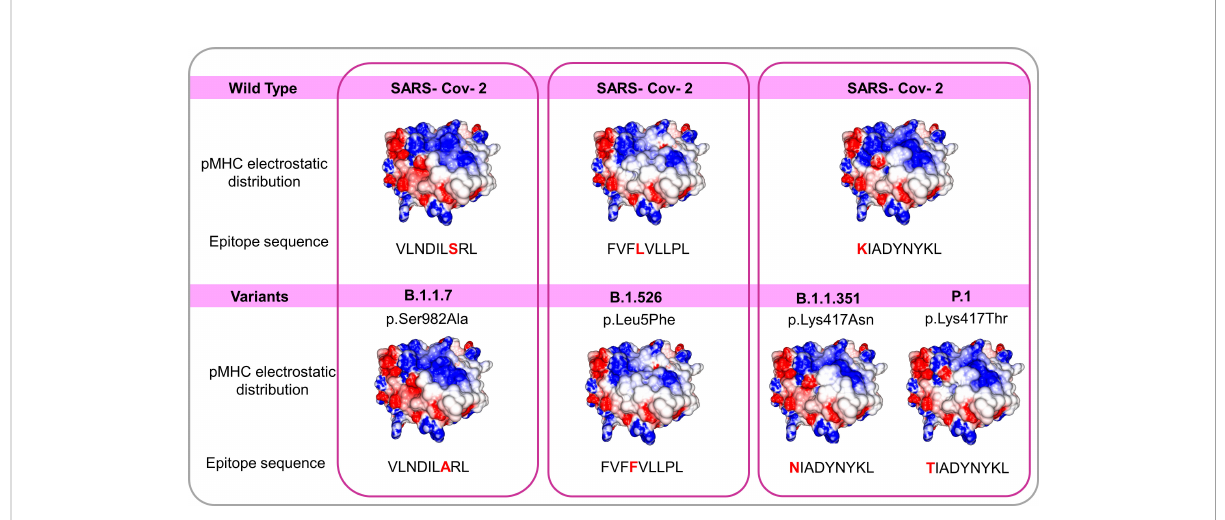
FIGURE 4 Comparisons among pMHCs carrying wild SARS-CoV-2 epitopes and the correspondent variant sequences in SARS-CoV-2 Spike ’ protein . The electrostatic distributions surfaces from the wild type and correspondent variants do not differ, even presenting amino acid changes in peptides suggesting a preserved TCR recognition. The variants B.1.1.7 B.1.526 B.1.1.351 and P.1 with their respective changes (S982A L5F K417N and K417T respectively) and correspondent epitope sequences.